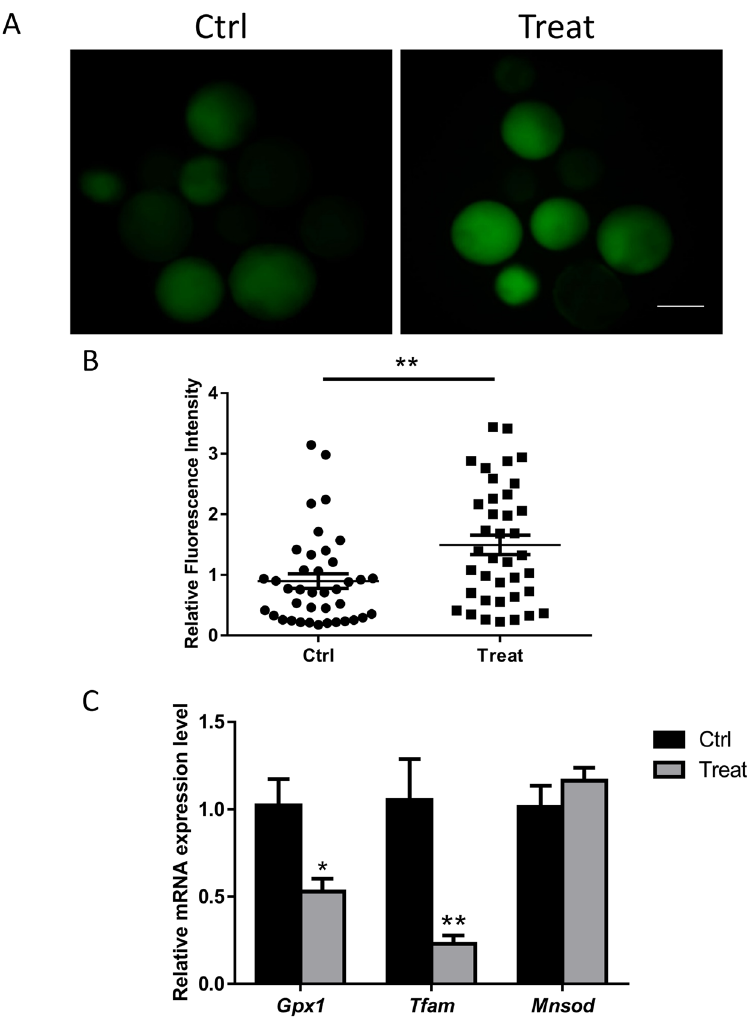
Figure 2. BPA increases ROS. ( A ) Staining for ROS in porcine blastocysts in the control and BPA-exposed groups. ( B ) Green fluorescence intensity was measured. ( C ) mRNA expression of Gpx1 , Mnsod , and Tfam in blastocysts with or without BPA. ** P < 0.01. Ctrl, control; Treat, treatment. Scale bar: 200 μ